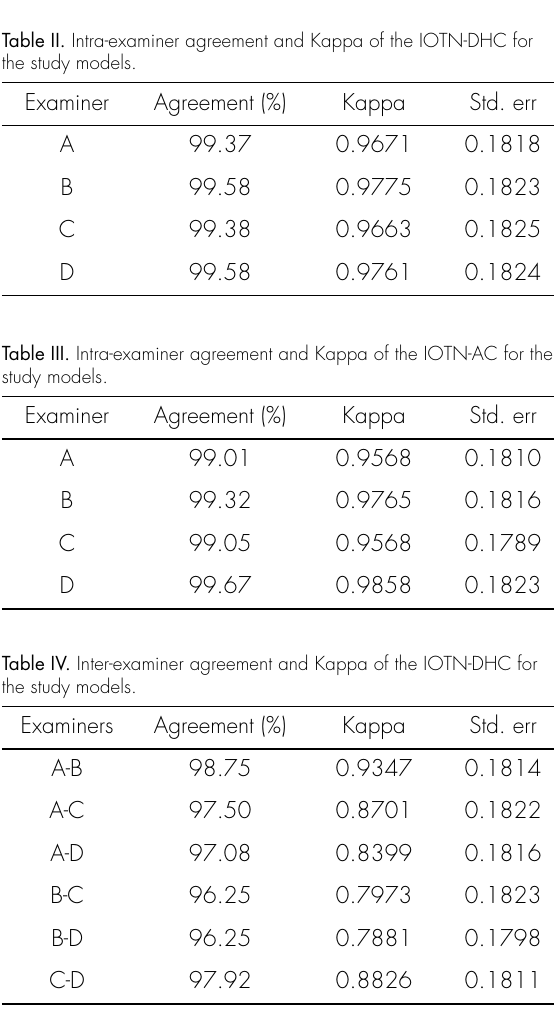
Table V. Inter-examiner agreement and Kappa of the IOTN-AC for the study models. Examiners